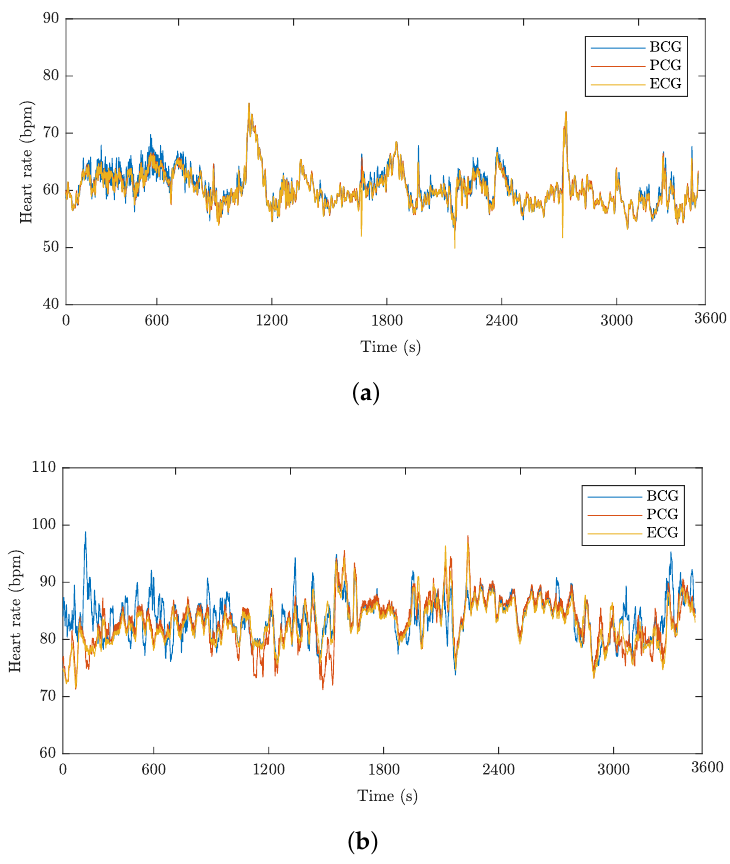
Figure 14. ( a ) The HR waveform for subject M1; ( b ) the HR waveform for subject